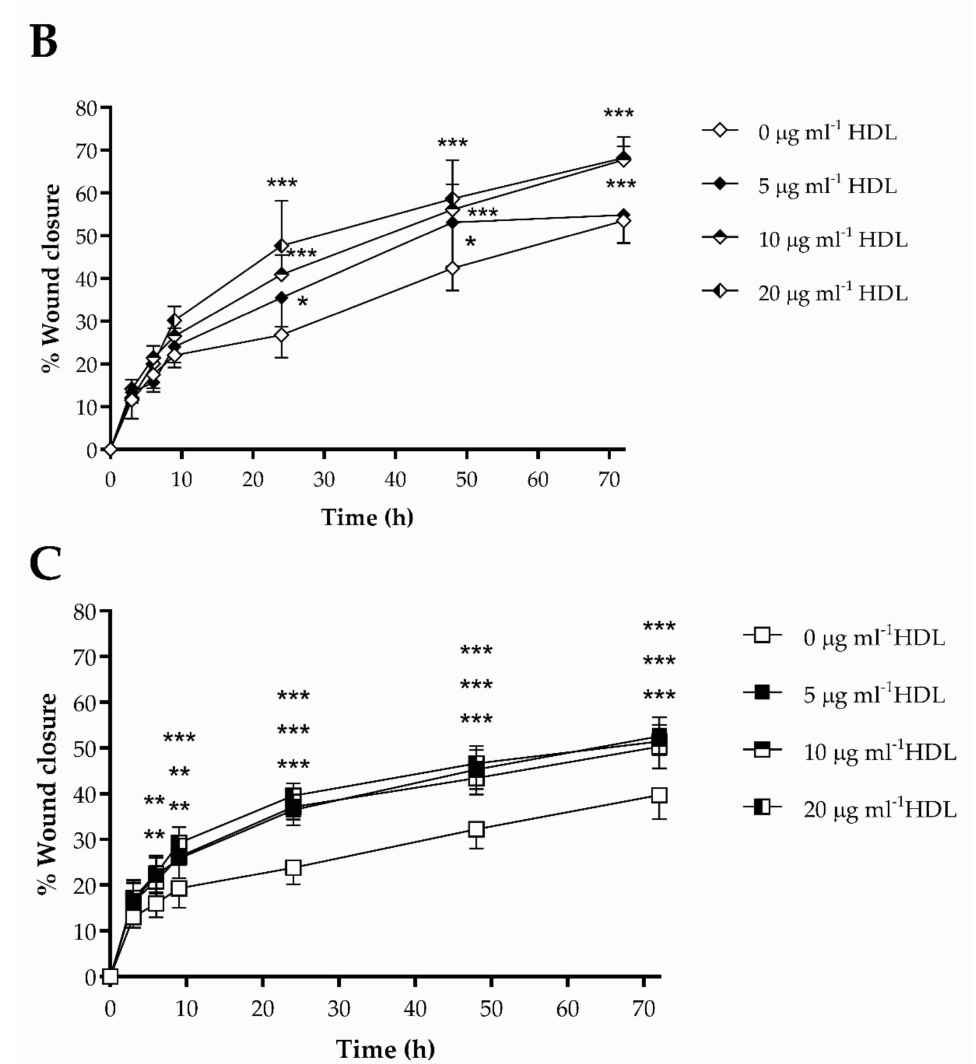
Figure 3. ‘Scrape’ wound healing, in the presence or absence of HDL (5–20 µ g mL − 1 ; 0–72 h), compared with the control (serum-free media) condition, by HKn, HDFn and HDFa, are shown in ( A – C ), respectively. Data are the mean ± SEM of three independent experiments (each performed using triplicate wells). The data were analysed using two-way ANOVA and Tukey post-hoc test; * p < 0.05; ** p < 0.01; *** p < 0.001. In ( C ), after 6 h, significance ( p < 0.01) from control is noted after treatment with HDL (5 µ g mL − 1 and 20 µ g mL − 1 ); at 9 h, significance is noted for 5 µ g mL − 1 ( p < 0.01), 10 µ g mL − 1 ( p < 0.001) and 20 µ g mL − 1 ( p < 0.001); for time points thereafter, significance ( p < 0.001) from control is noted for all three concentrations